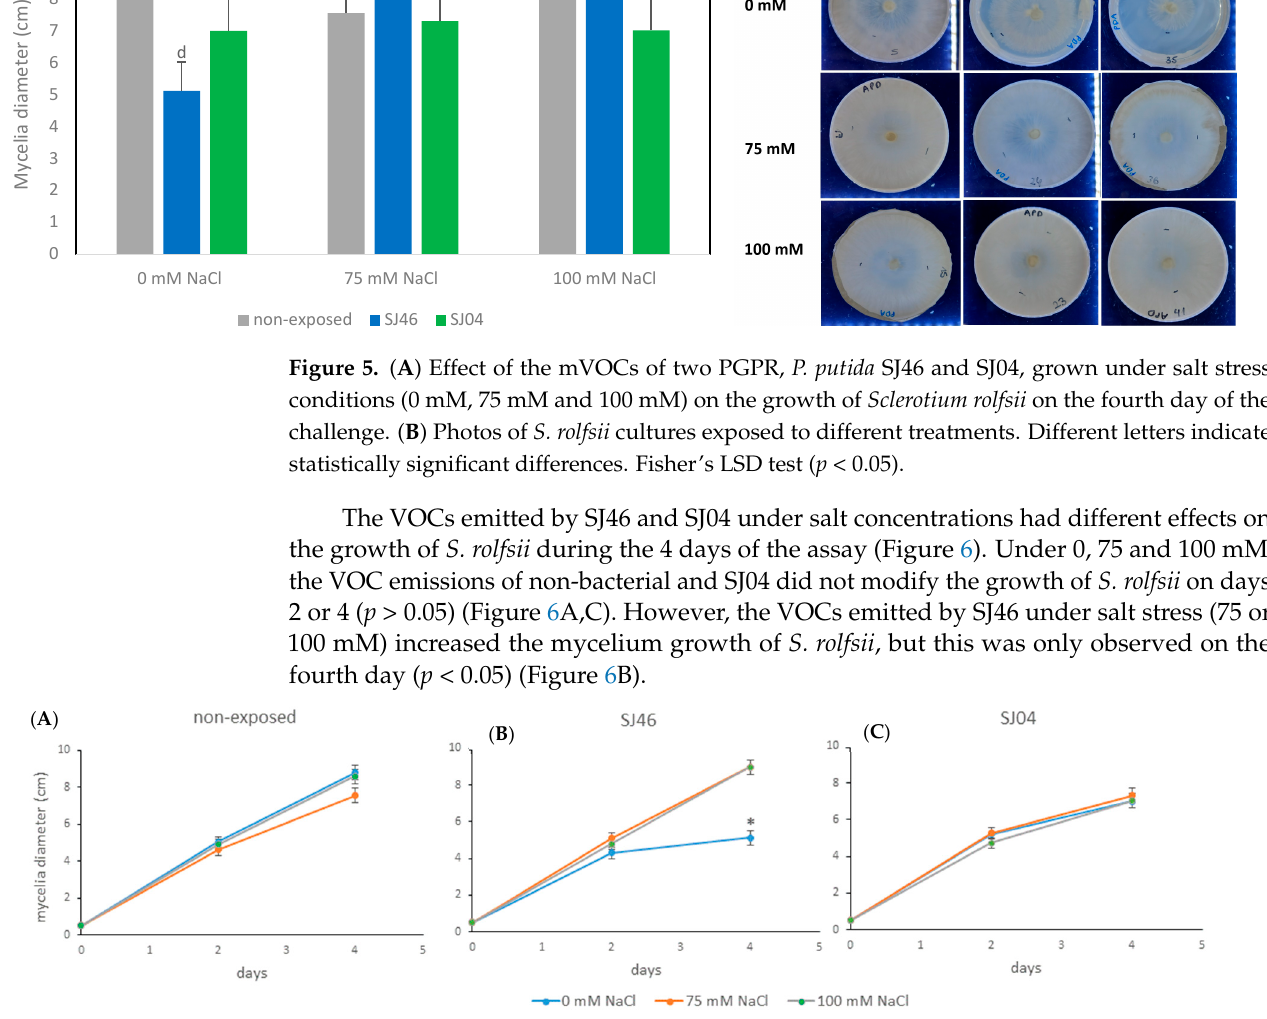
Figure 6. Effect of mVOCs of ( A ) control (non-exposed), ( B ) P. putida SJ46 and ( C ) SJ04 on S. rolfsii growing under different salt levels. “*” above the columns indicates a significant difference at p < 0.05.